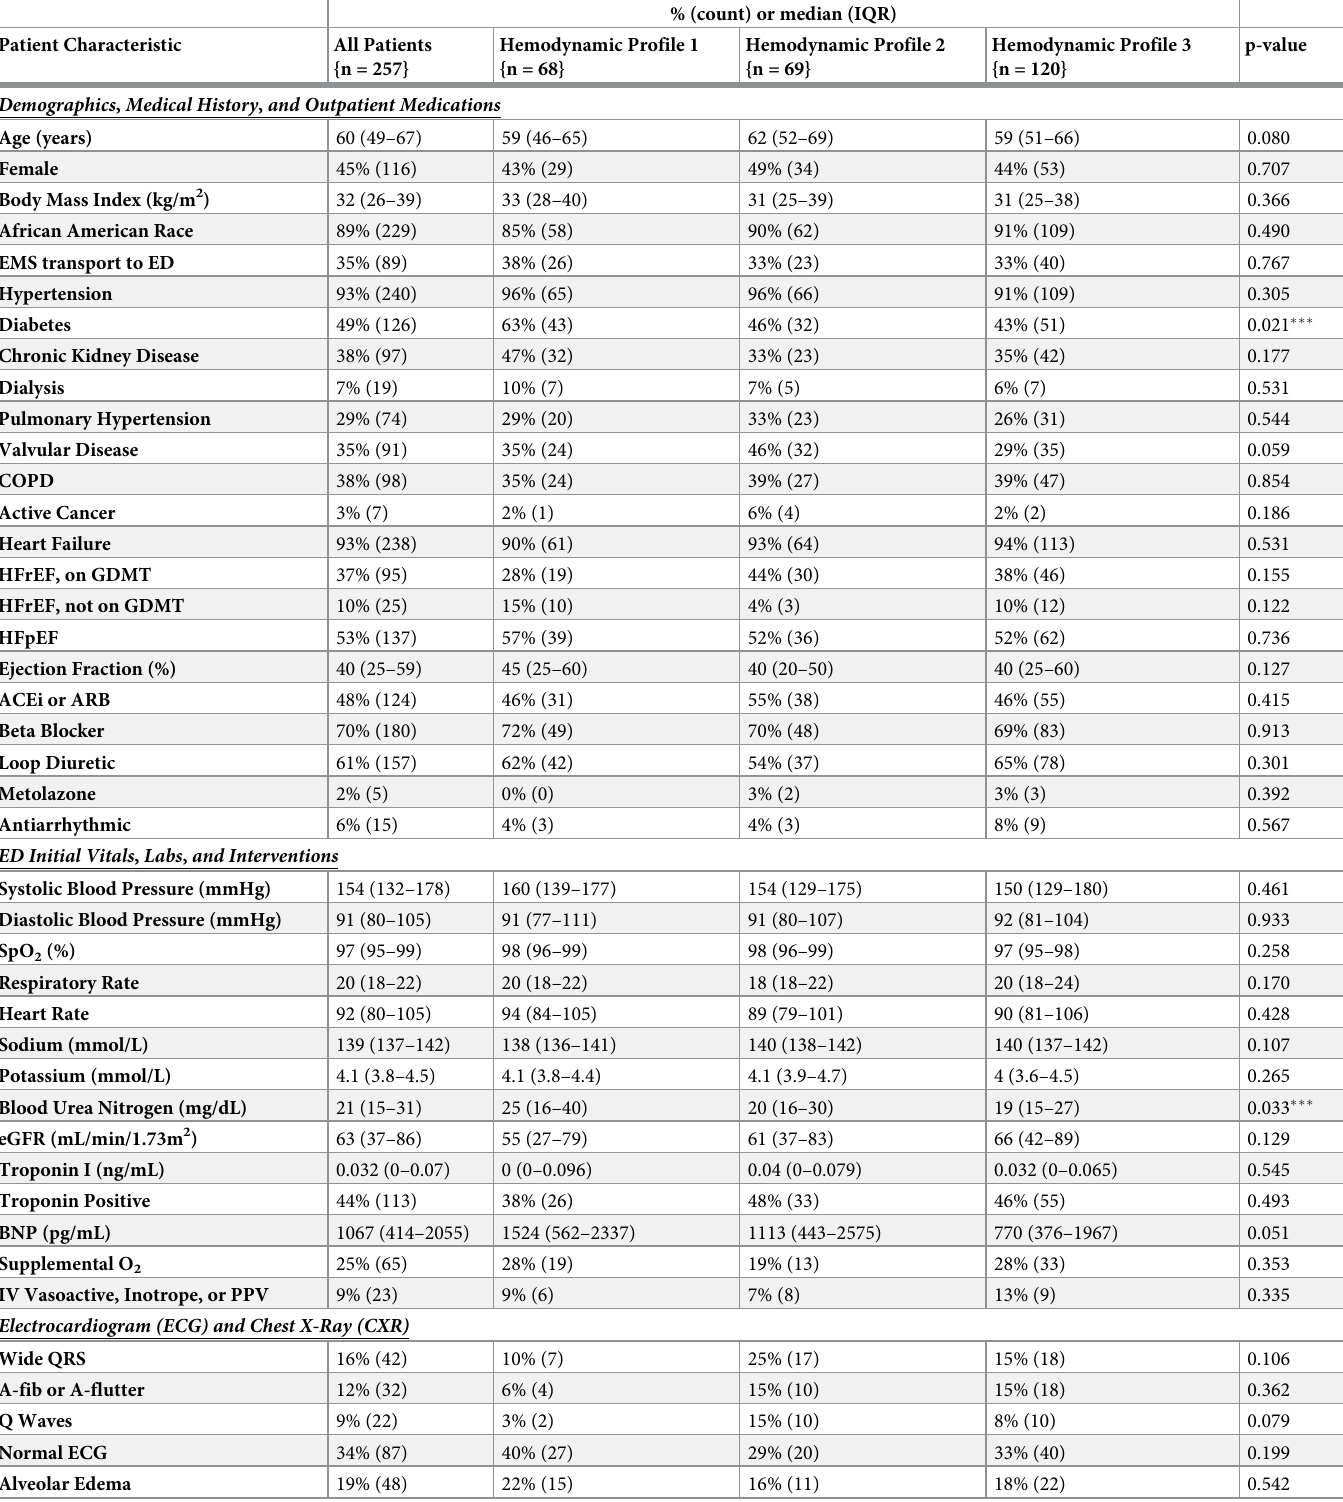
Table 1. Clinical characteristics of patients in the validation